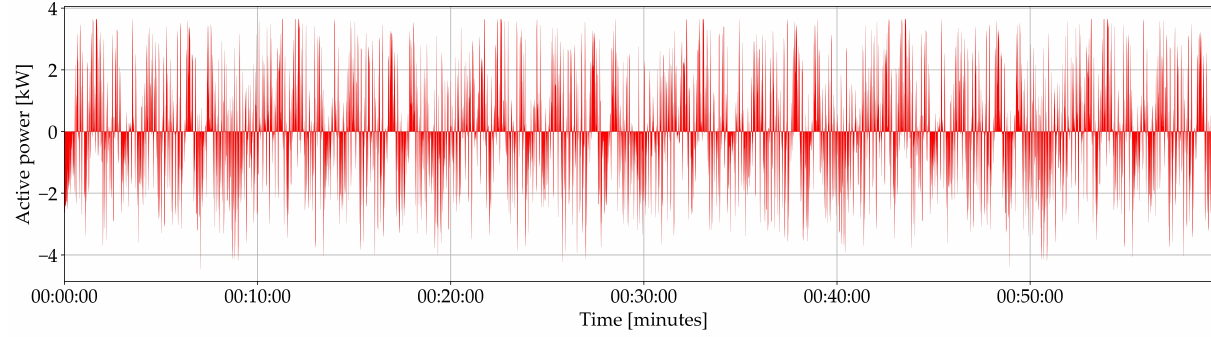
Figure 13. One-hour dispatch profile of